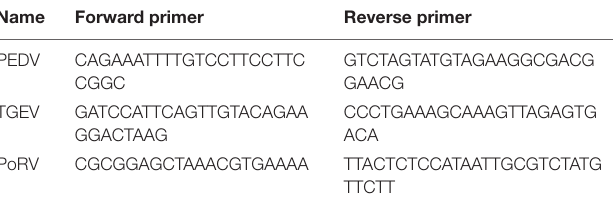
TABLE 2 | Primers for absolute quantitative method qRT-PCR in this